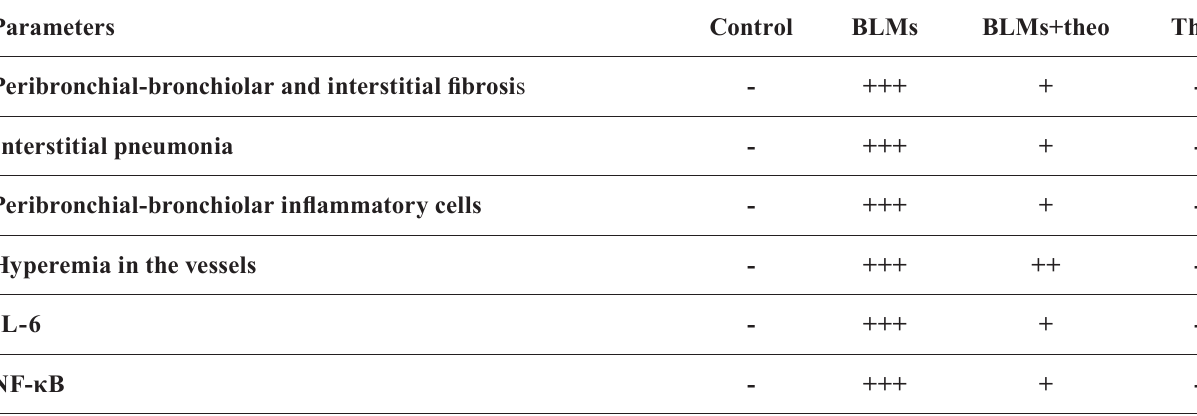
TABLE I - S cores of immunohistochemical and histopathological findings